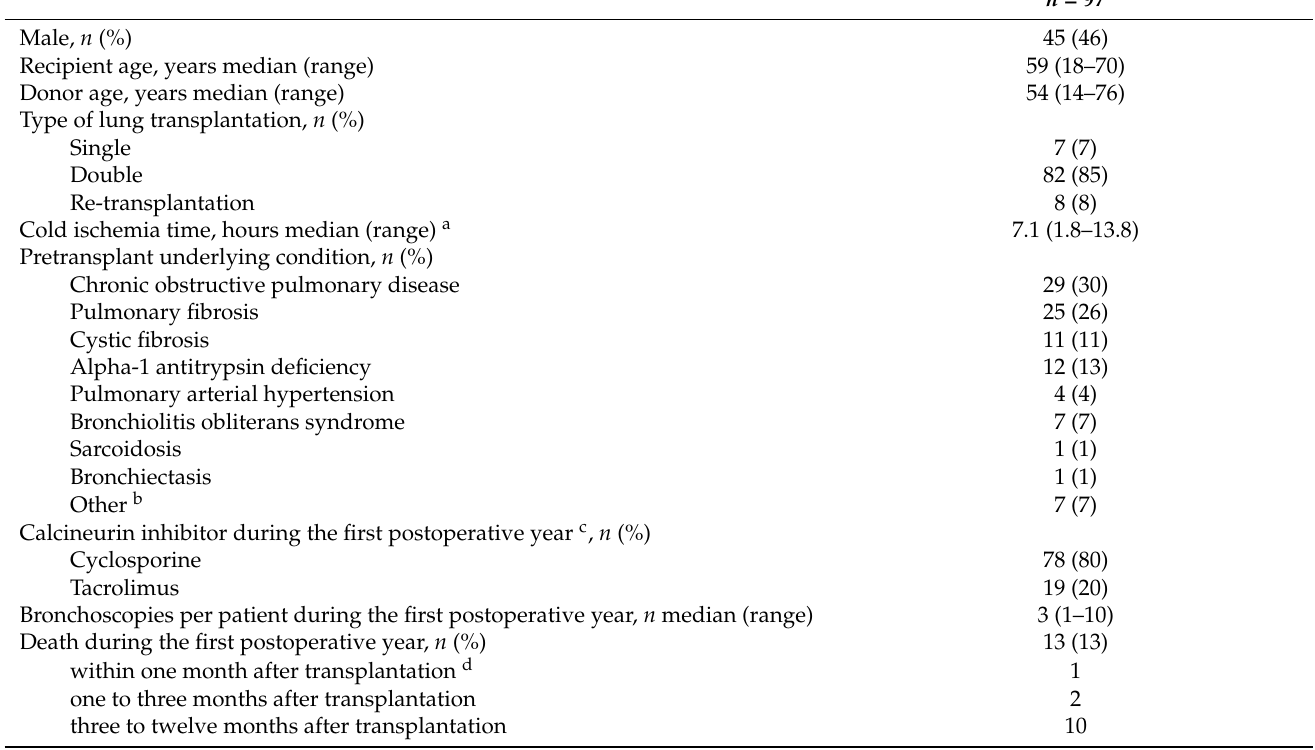
Table 1. Characteristics of the study cohort.